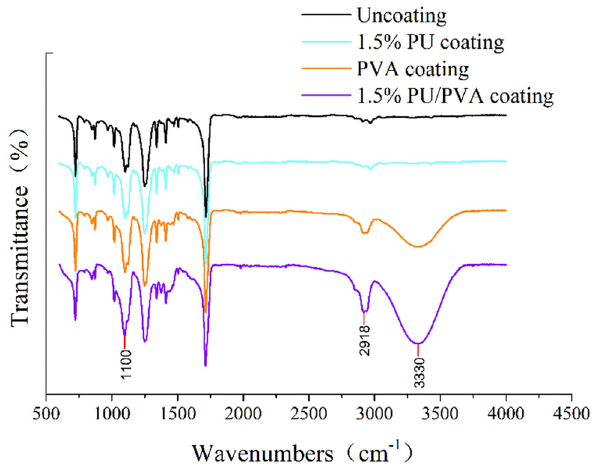
Figure 8: FTIR spectra of uncoated harness cord and coated harness cords with PU ( 1.5% ) , PVA, and PU ( 1.5% )